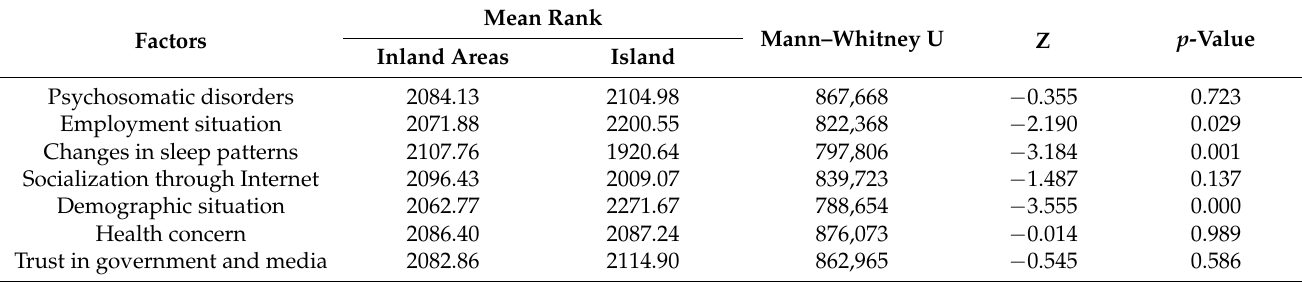
Table 5. Differences between inland areas and